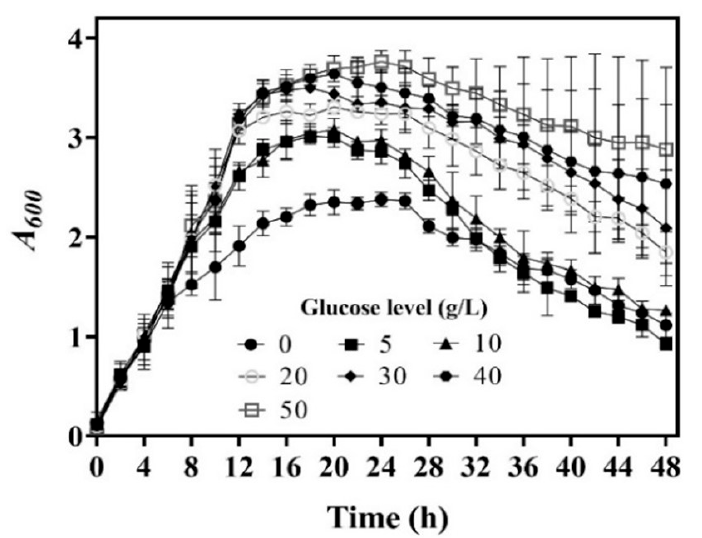
Figure 1. Effects of glucose level on cell growth of L. brevis CD0817. Cell growth is presented as A 600 ( n = 3). A 600 , absorbance at 600 nm.